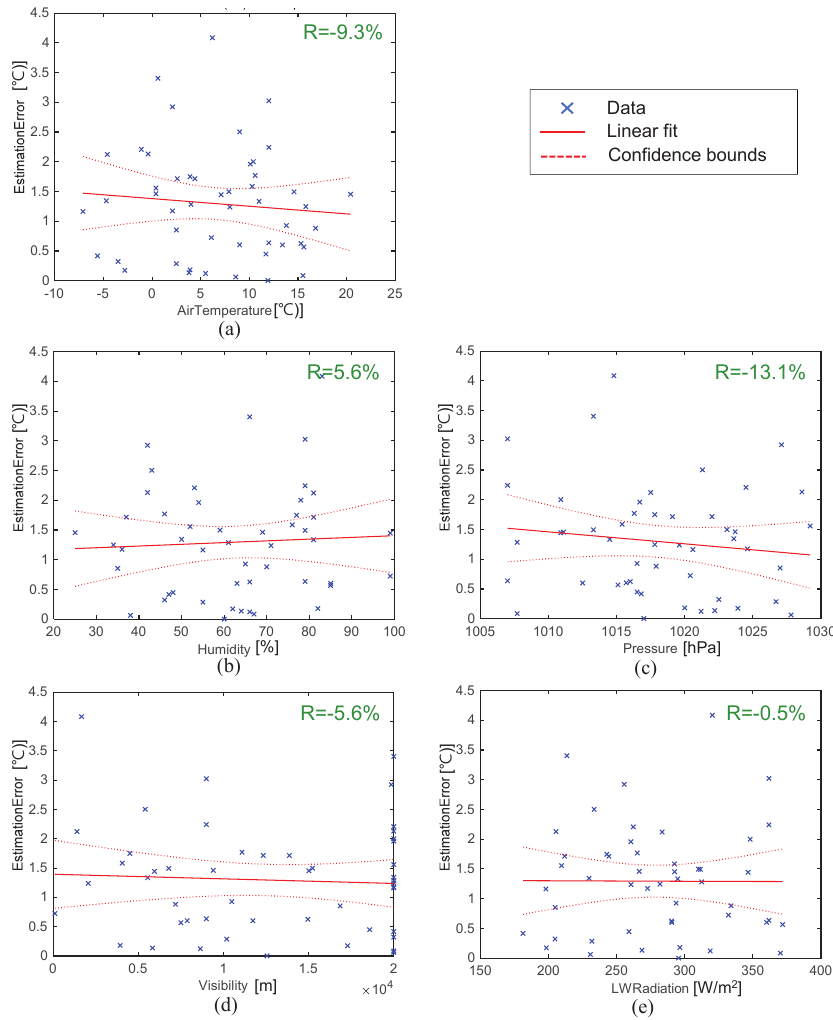
Figure 23. Examples of air temperature images measured by the proposed VisualAT method for different months: ( a ) estimation error vs. air temperature; ( b ) estimation error vs. humidity; ( c ) estimation error vs. pressure; ( d ) estimation error vs. visibility; ( e ) estimation error vs. long wave thermal